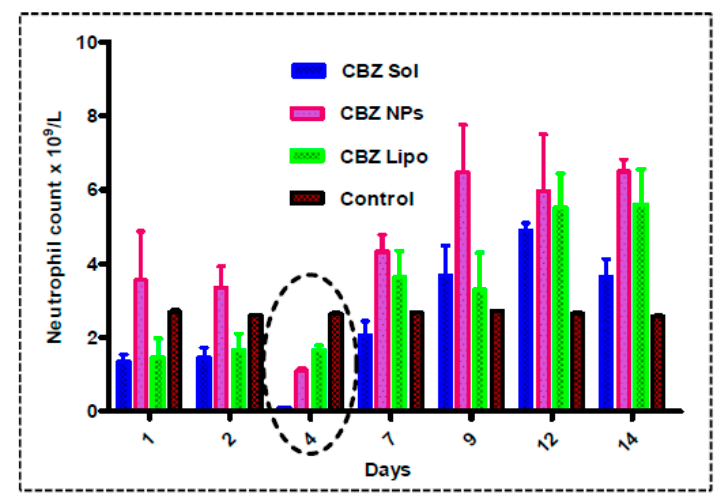
Figure 9. Neutropenic study: The graph representing neutrophil count until 14 days after the administration of CBZ micellar solution, CBZ NPs, and CBZ liposomes at 2.5 mg/kg dose in female Sprague–Dawley (SD) rats in comparison with saline control. The neutropenic effect in animals showed that there was a drastic reduction in neutrophil count (0.1025 × 10 9 /L) in animals administered with CBZ micellar solution on the fourth day. A depletion in neutrophil count was less observed in animals administered with CBZ liposomes (1.6725 × 10 9 /L) and CBZ NPs (1.1 × 10 9 /L) in comparison to CBZ micellar solution and saline control (2.635 × 10 9 /L).